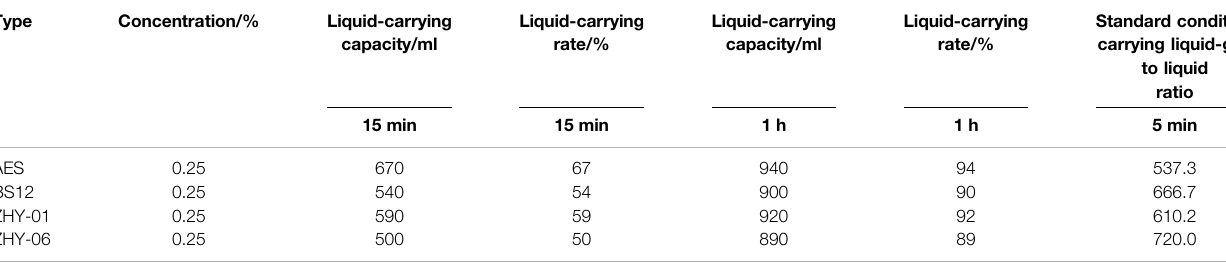
TABLE 1 | Liquid-carrying capacity of different foaming agents at 0.25% concentration.